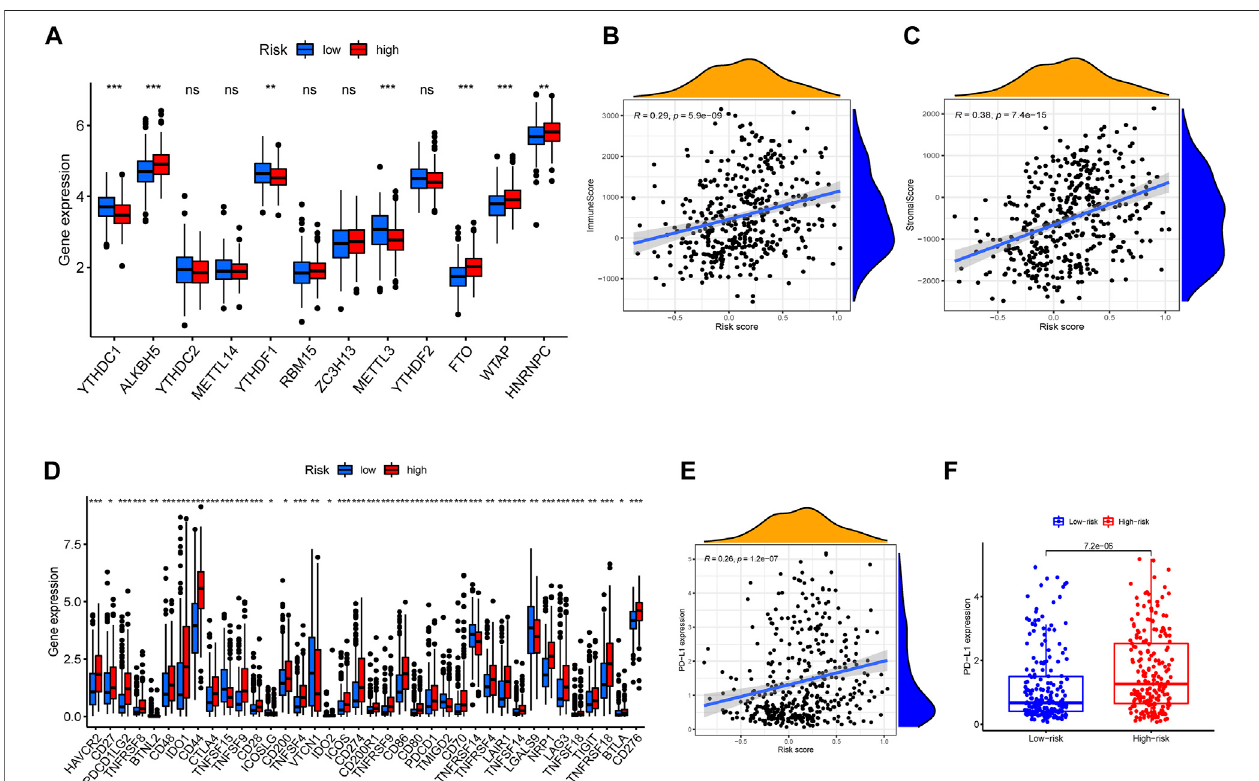
FIGURE 8 | m6a correlation analysis and immune checkpoint correlation analysis. (A) Expressions of m6a-related genes in different risky groups. (B,C) The correlation between tumor microenvironment feature and risk scores. (D) Gene expression of immune checkpoint sites in distinct risk groups. (E) Correlation analysis between risk scores and expression level of PD-L1 gene. (F) Comparison of PD-L1 expression levels between high- and low-risk groups.